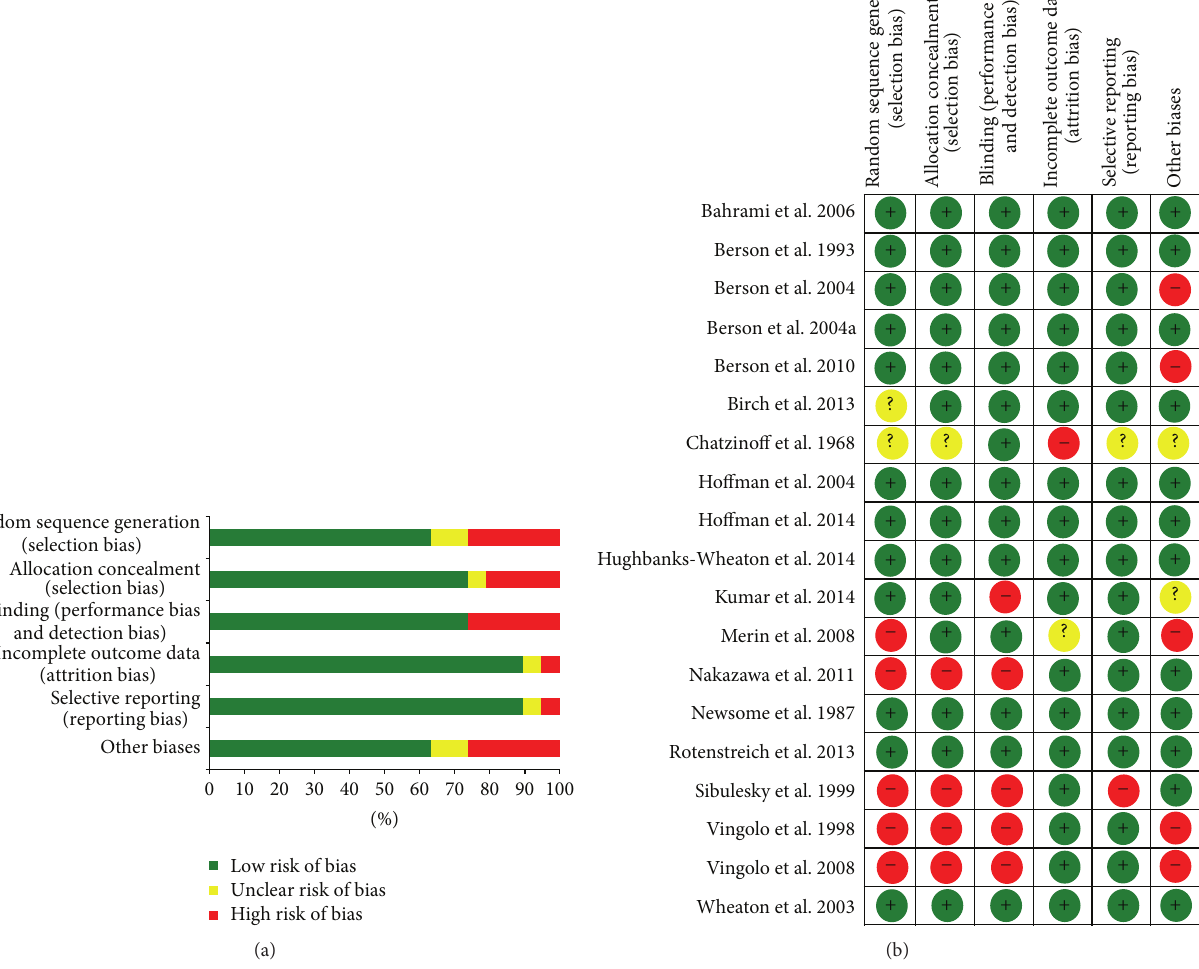
Figure 2: Risk of bias graph (a) showing authors’ judgements about each risk of bias item presented as percentages across all included studies. Risk of bias summary (b) reviewing authors’ judgements about each risk of bias item for each included